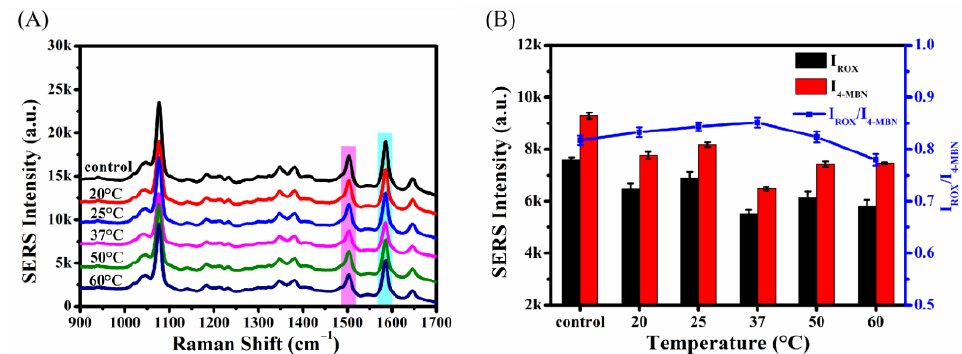
Figure 7. The results of optimizing the incubation temperature of SERS probes and enrofloxacin. ( A ) SERS spectra of samples prepared by incubating SERS probes and enrofloxacin at different temperatures (control: SERS probes incubated with 0.5× MOPS buffer at 25 °C). ( B ) Intensities of SERS signals of ROX at a Raman shift of 1503 cm −1 and 4-MBN at a Raman shift of 1586 cm −1 and their corresponding ratios.